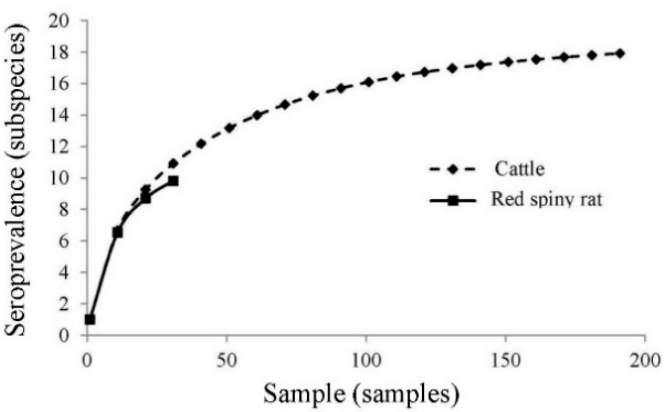
Figure 2. Seroprevalence accumulation curves of cattle and red spiny rat in Salakphra Wildlife Sanctuary.